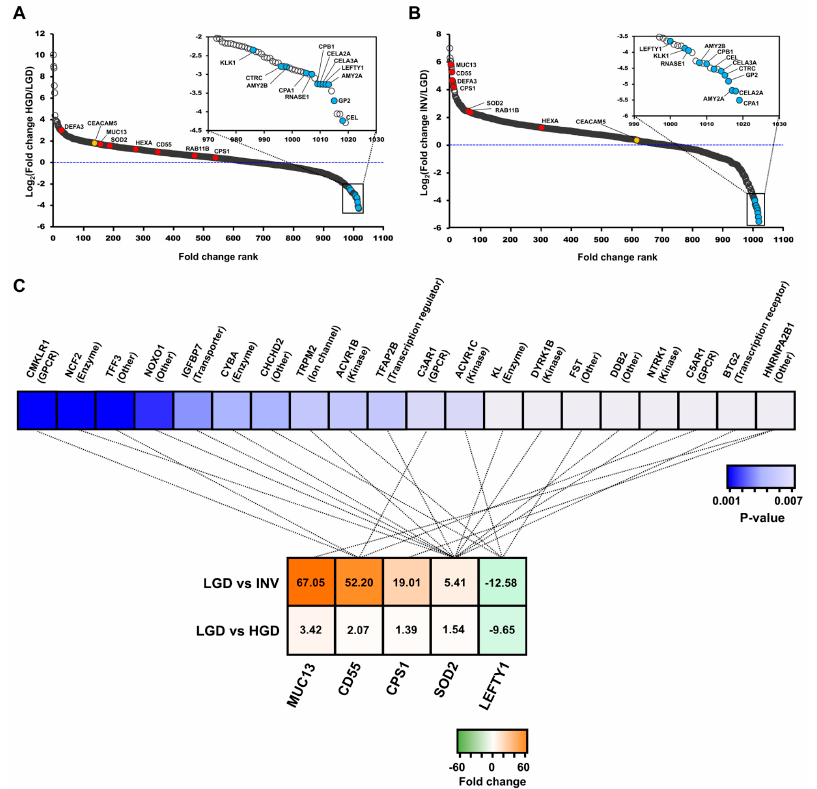
Figure 6. The dynamic range of protein fold-changes in comparisons 1 and 3 and the results of upstream regulator analysis in Ingenuity Pathway Analysis (IPA). The dynamic range with marked fold-changes of the 19 final marker candidates in comparisons 1 (LGD versus HGD) ( A ) and 3 (LGD versus invasive IPMN) ( B ). The red and blue dots indicate the log2-transformed fold-changes of the 7 upregulated and 12 downregulated proteins. The yellow dot represents the log2-transformed fold-change of CEA protein. ( C ) Five potential markers (MUC13, CD55, CPS1, SOD2, and LEFTY1) and their upstream regulators are connected by dotted lines. The molecular types of each upstream regulator are shown in parentheses. Each marker candidate is listed in order of decreasing fold-change, whereas the upstream regulators are listed in order of increasing p-values. LGD, low-grade dysplasia; HGD, high-grade dysplasia; INV, invasive IPMN.